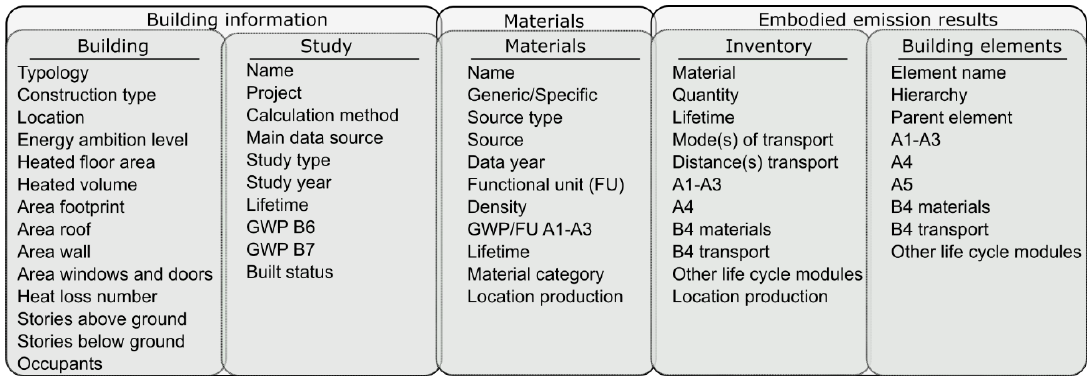
Figure 1. The main information stored in the three components of the database.